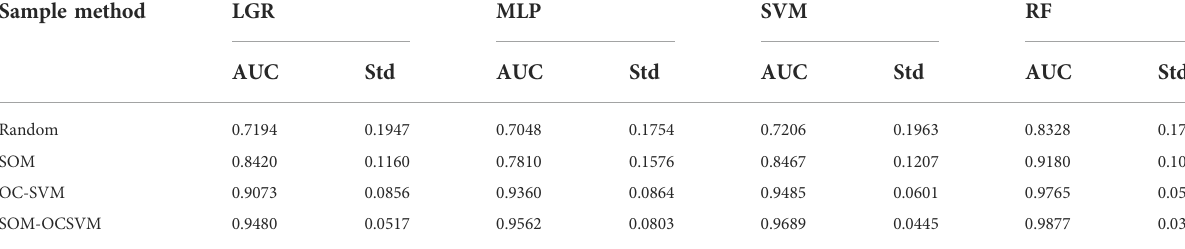
TABLE 3 AUC and Std of four machine learning models with different non-landslide